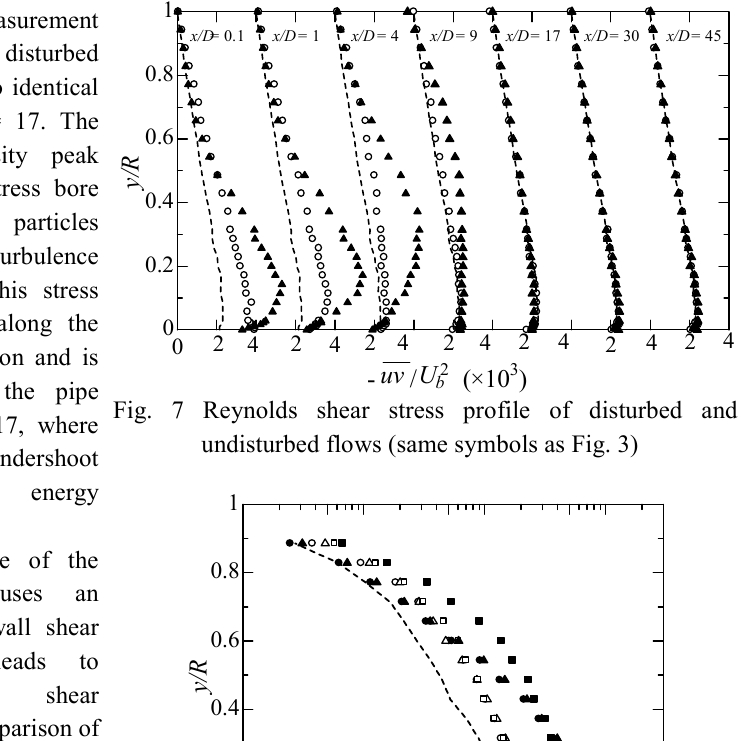
Fig. 7 Reynolds shear stress profile of disturbed and undisturbed flows (same symbols as Fig. 3)